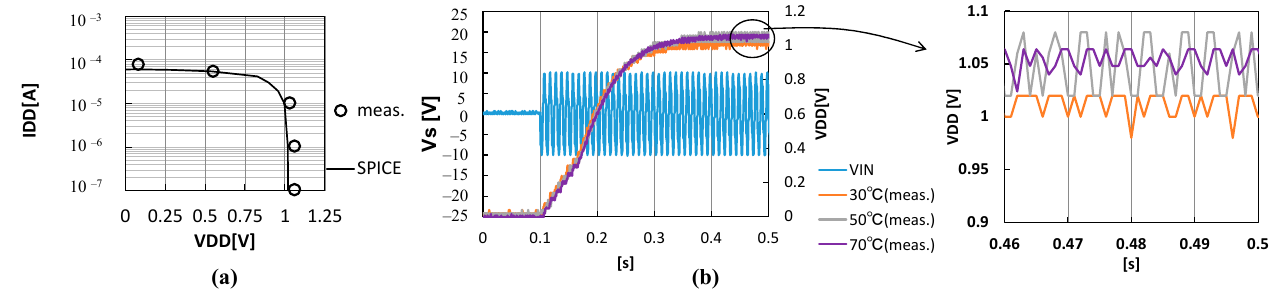
Figure 9. Measured I DD vs. V DD ( a ) and waveform ( b ). Table 2. Measured V DD vs. temperature. Temp.